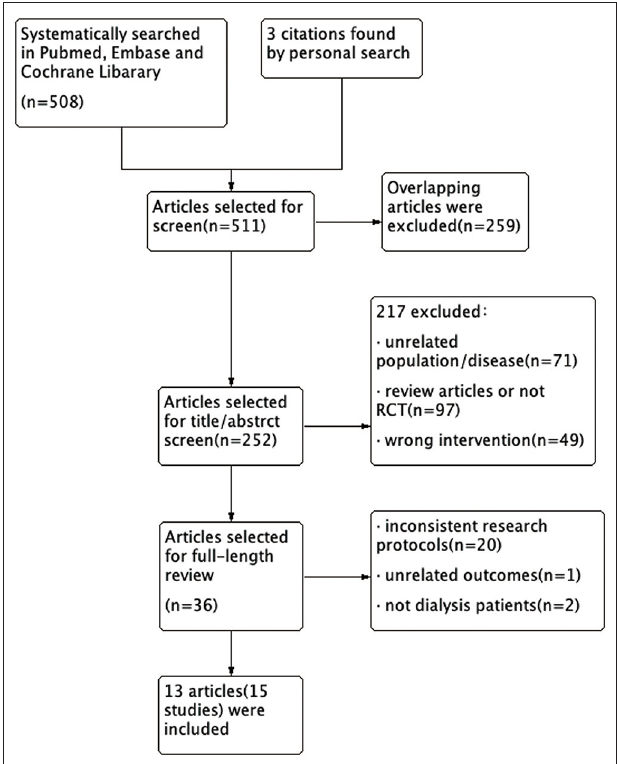
FIGURE 1 | Flow diagram of the literature search process.